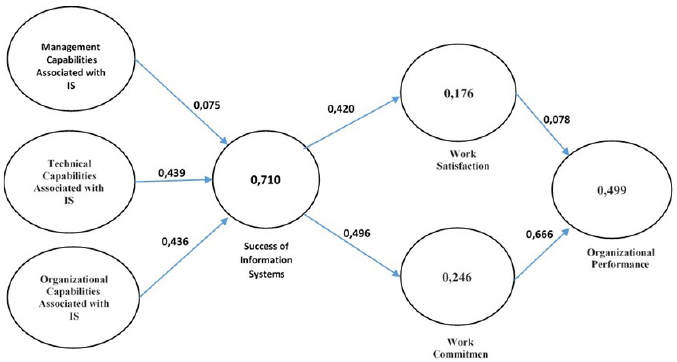
Figure 1. Structural